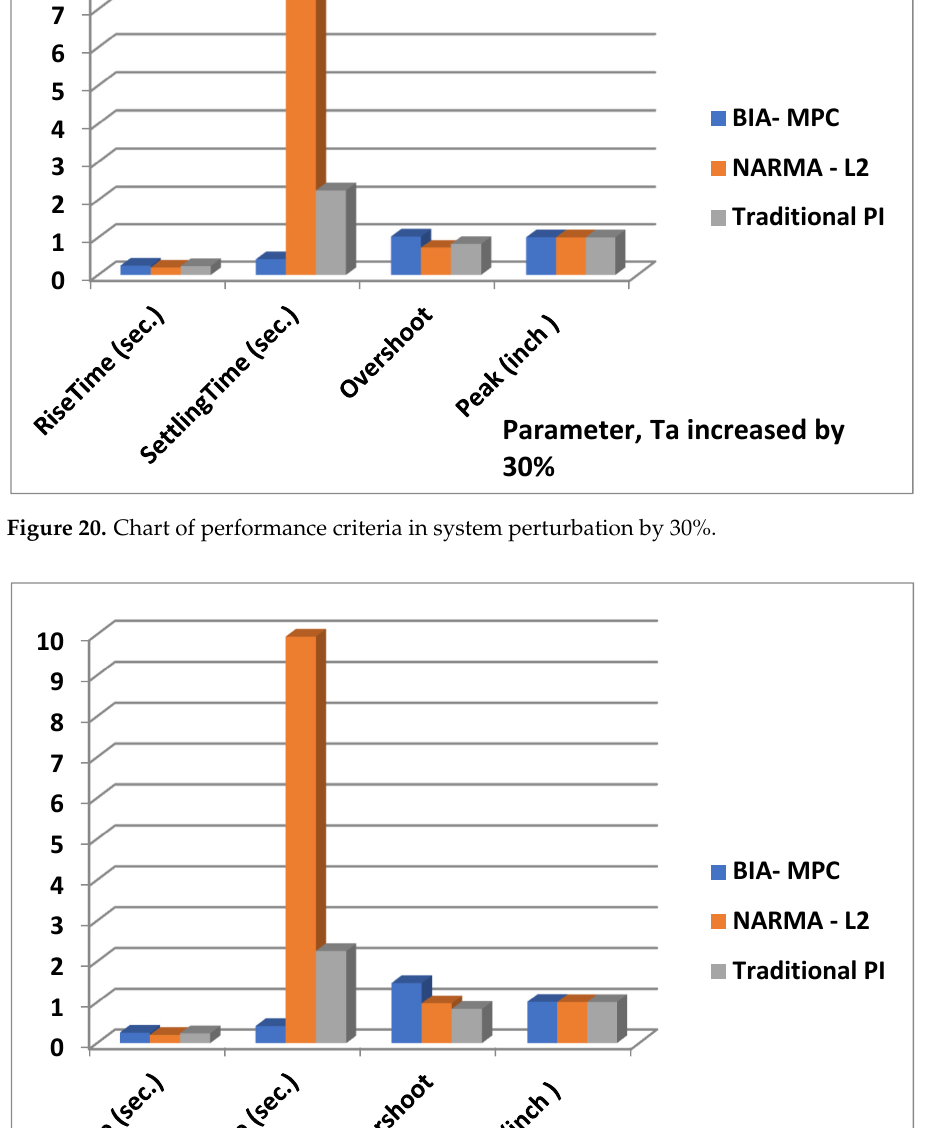
Figure 21. Chart of performance criteria in system perturbation by 40%.